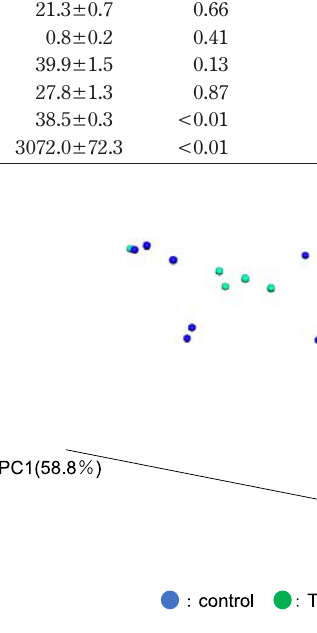
Figure 1 Comparative analysis of vaginal microbiome profiles between the PD and TPD or control groups. A. Alpha diversity of the vaginal microbiome. The rare fraction curve was constructed using weighted UniFrac analysis. Red lines indicate the PD group and blue lines indicate the TPD and control groups. B. A PCA plot was constructed using weighted UniFrac analysis. Red, green, and blue circles indicate the PD, TPD, and control groups, respectively.